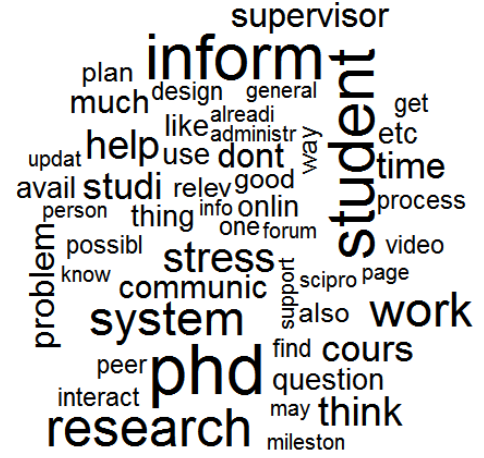
Figure 2. Word cloud of the most frequently used words in the responses and reflections to the open